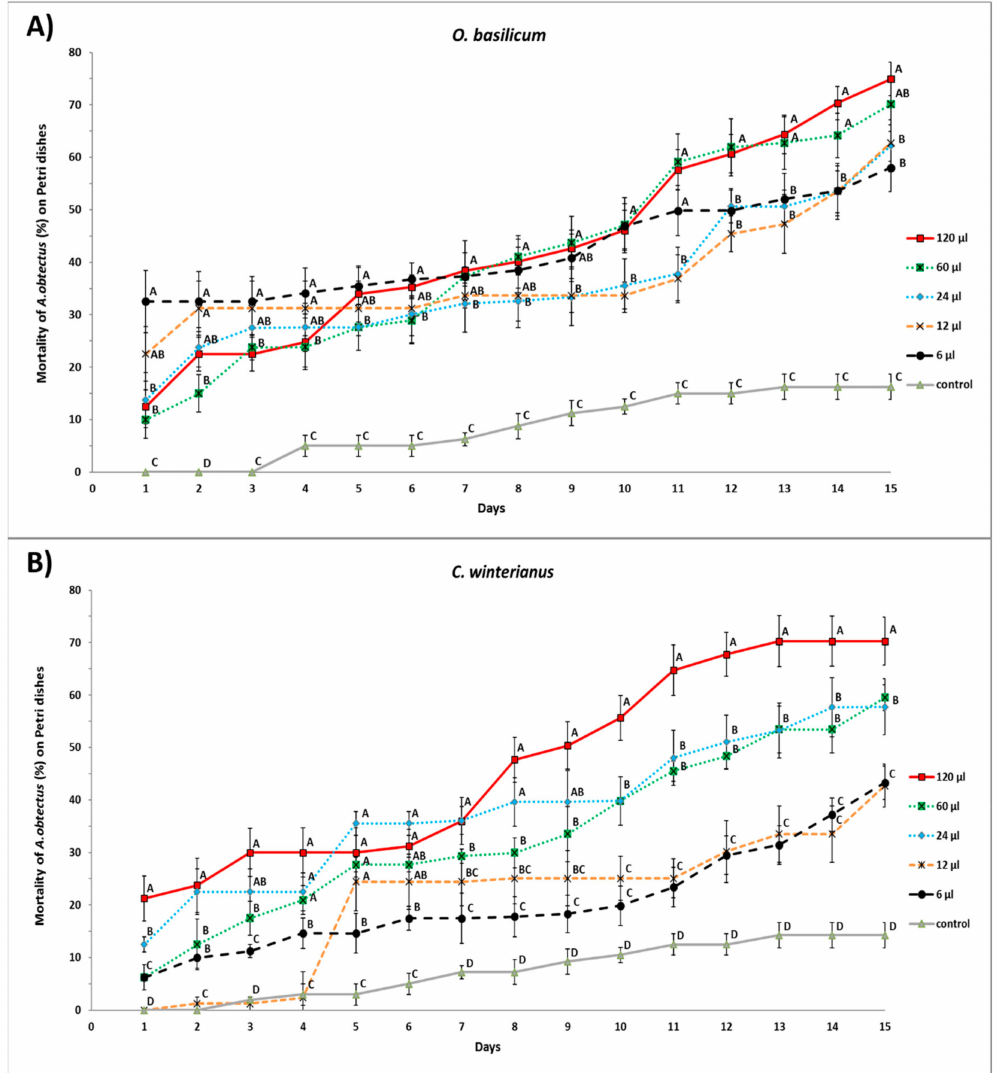
Figure 1. Accumulated mortality of A. obtectus on Petri dishes exposed to di ff erent doses of O. basilicum ( A ) and C. winterianus ( B ) essential oils. Di ff erent capital letters indicate significant di ff erences among doses and control for the same day; least significant di ff erence (LSD) test at 0.05. The symbols represent the mean of four replicates for each dose. Vertical bars represent the Standard Error (SE) of the